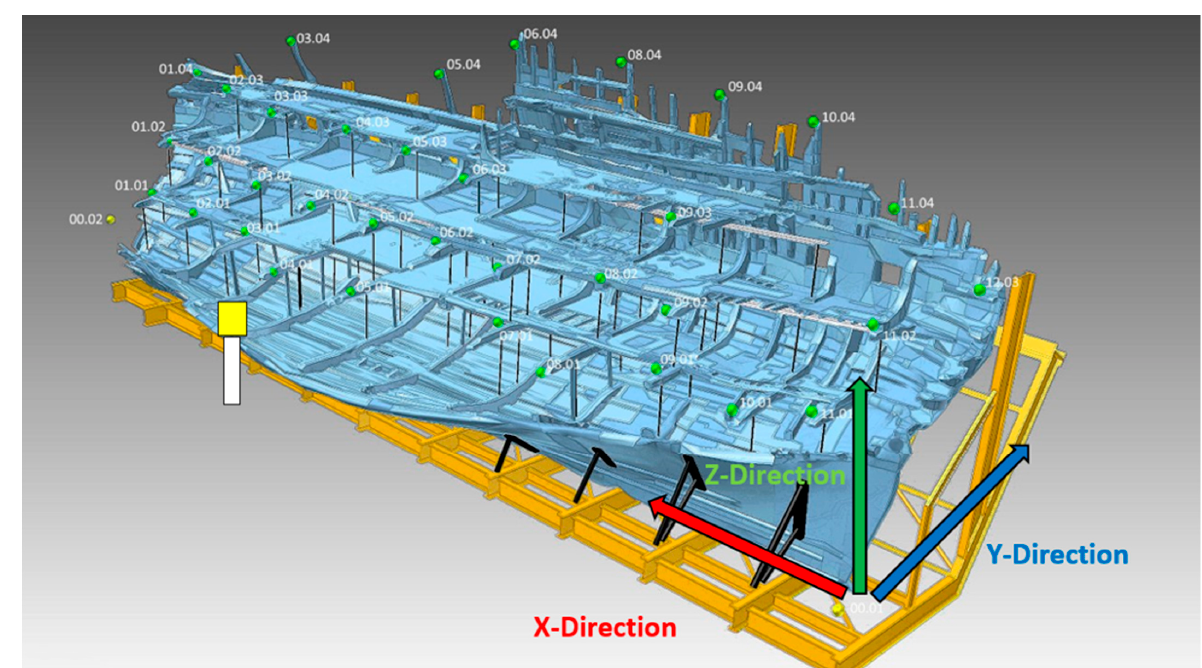
Figure 1. Schematic of the Mary Rose showing the location of the laser targets on the ship and the laser scanner. The X direction is positive from stern to bow. The Y direction is positive from port to starboard and the Z direction is positive from the ground up.